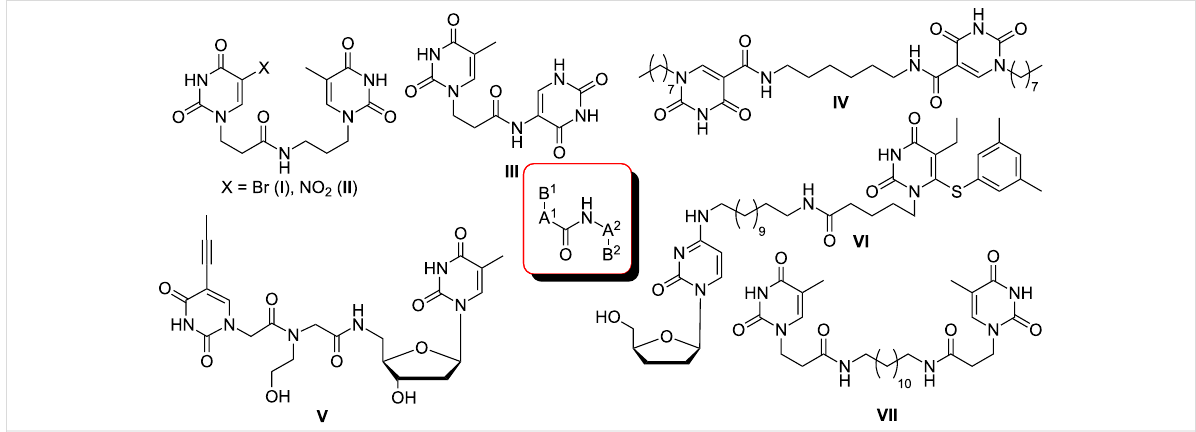
Figure 1: Examples of symmetrical and unsymmetrical α , ω -nucleobase amide-conjugated systems.